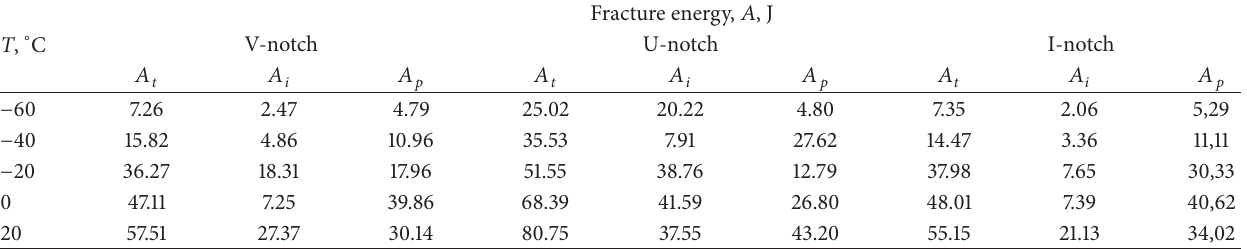
Table 3: Fracture energy of 17Mn1Si steel specimens with different notches under impact bending.